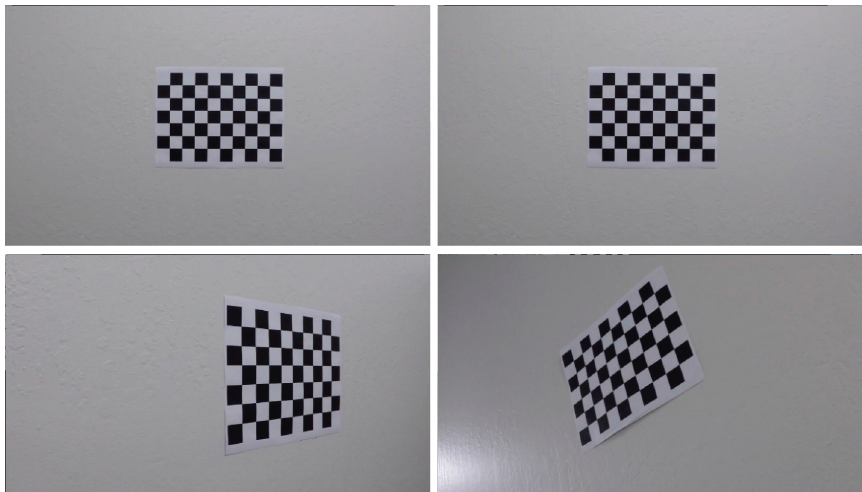
Figure 3: Illustrating image of